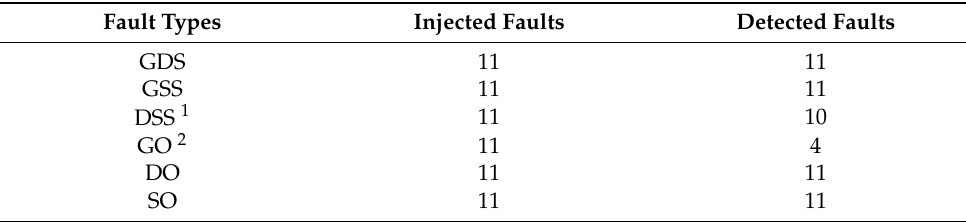
Table 2. Simulation results of injected and defected fault.